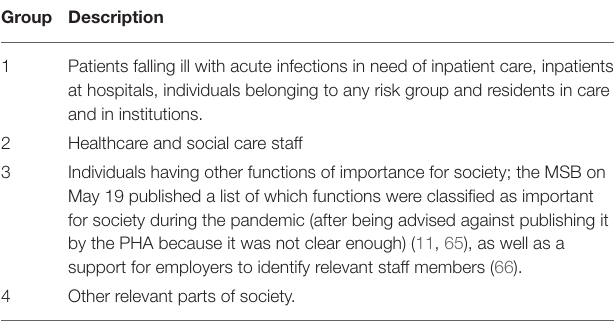
TABLE 2 | Priority groups presented in the first national strategy for COVID-19 testing. Group